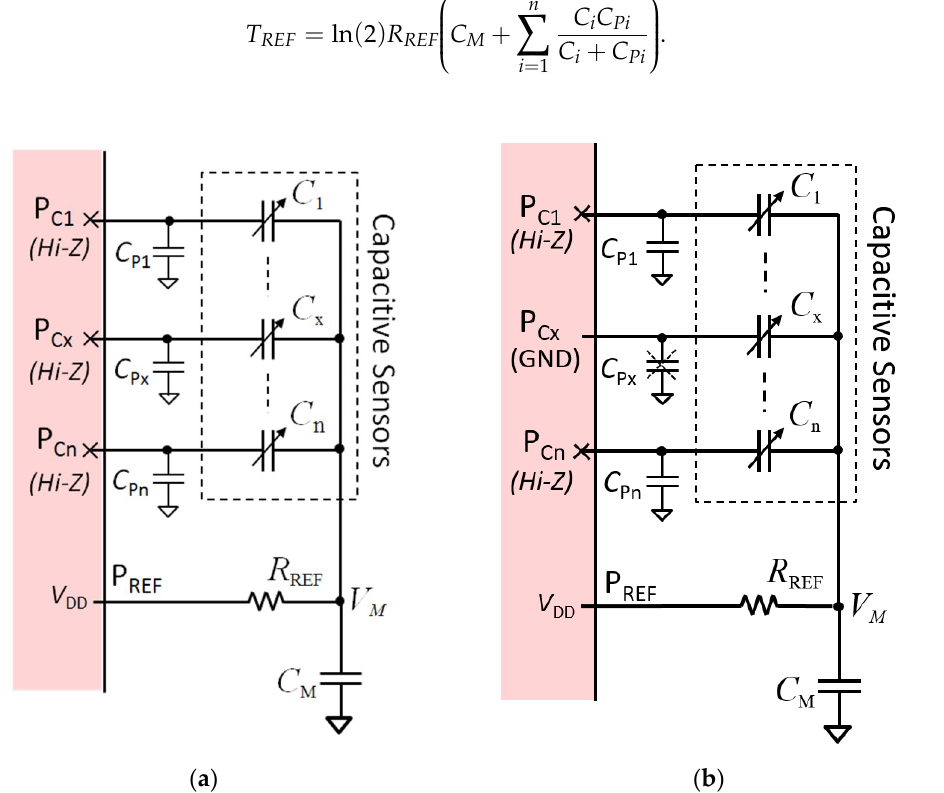
Figure 4. Effect of the parasitic capacitance C Px of the microcontroller‐based interface: ( a ) equivalent circuit during measurement with C M and ( b ) during measurement with C M + C x .